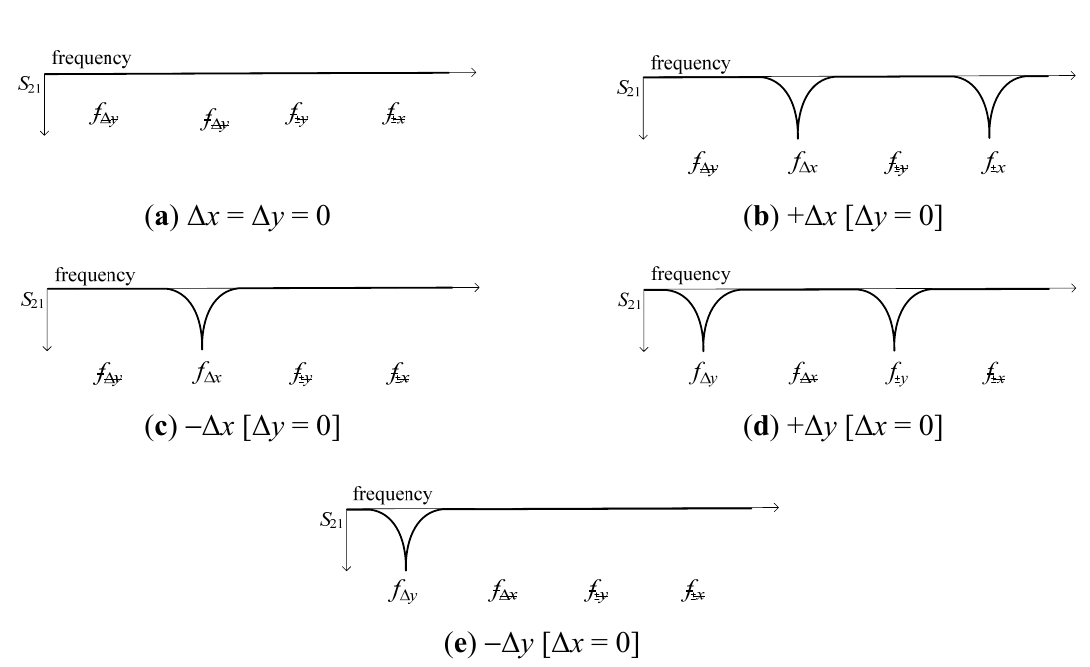
Figure 4. Transmission coefficient S